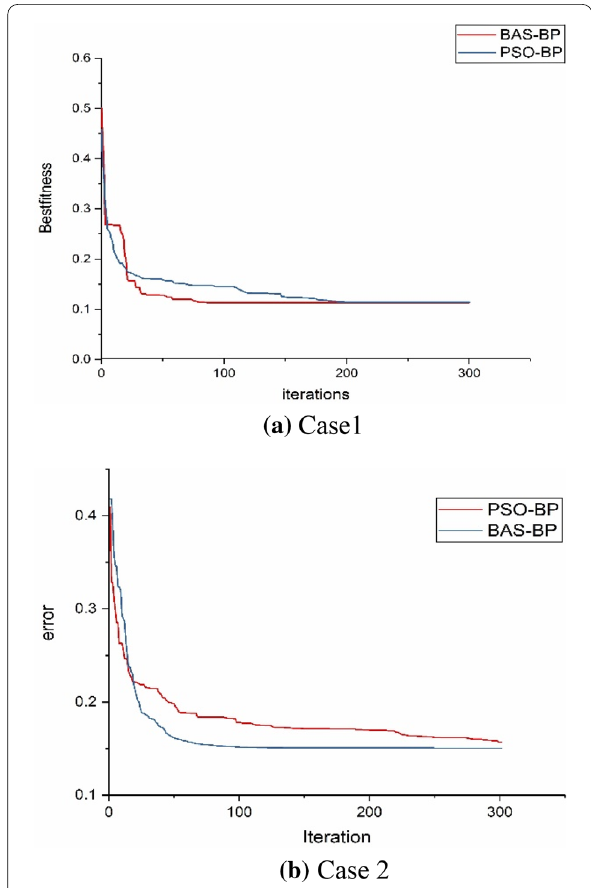
Figure 10 Test comparison chart Figure 11 Error iteration